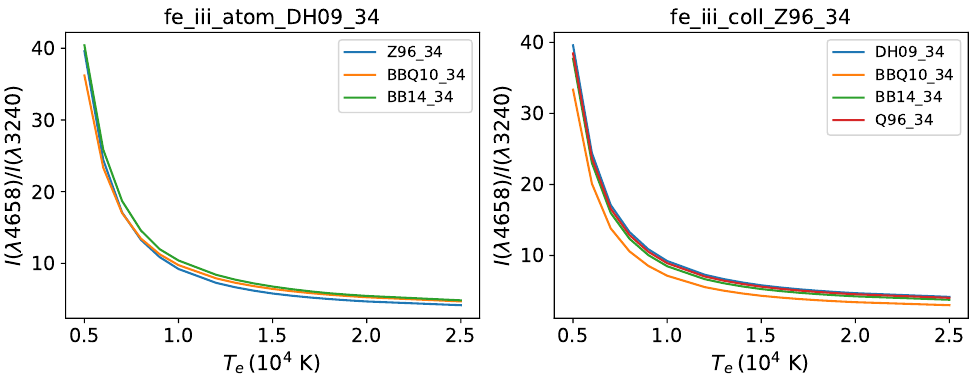
Figure 3. Temperature behavior of the [Fe III ] I ( λ 4658 ) / I ( λ 3240 ) emissivity ratio at n e = 2.1 × 10 4 cm − 3 for different atomic datasets. Left panel : dataset atom_DH09_34 with three coll datasets (Z96_34, BBQ10_34, and BB14_34). Right panel : dataset coll_Z96_34 with four atom datasets (DH09_34, BBQ10_34, BB14_34, and